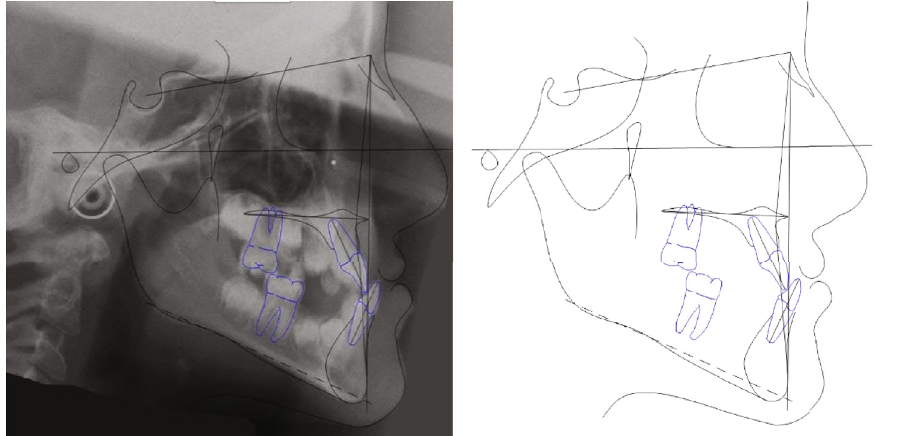
Figure 3: Case no. 1 tracings (pretreatment).